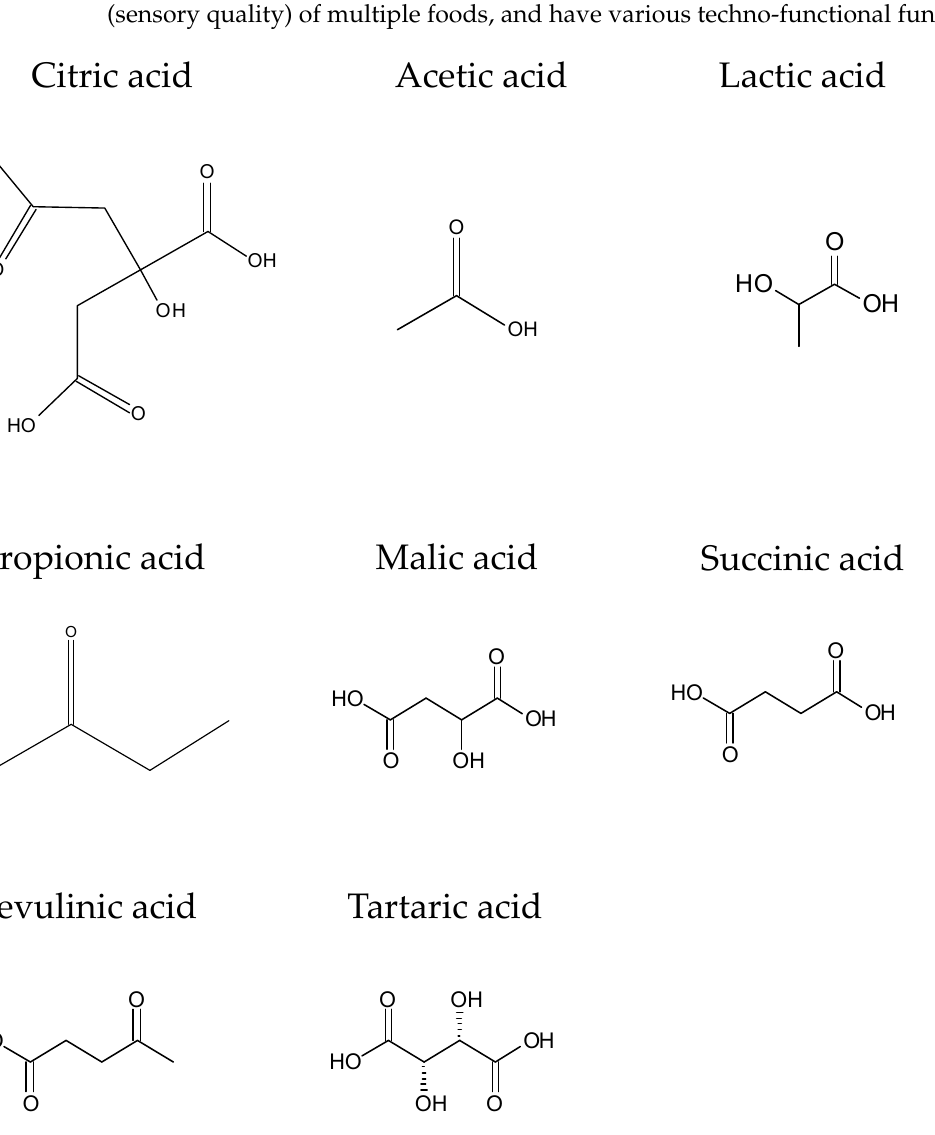
Figure 1. Chemical structure of organic acids commonly used in meat products.